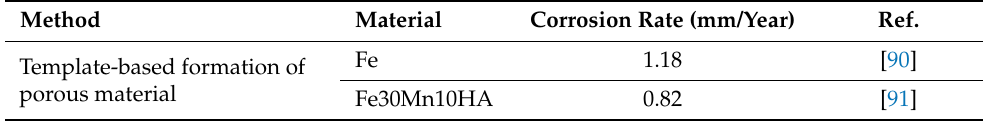
Table 9. Corrosion rates for porous Fe-based